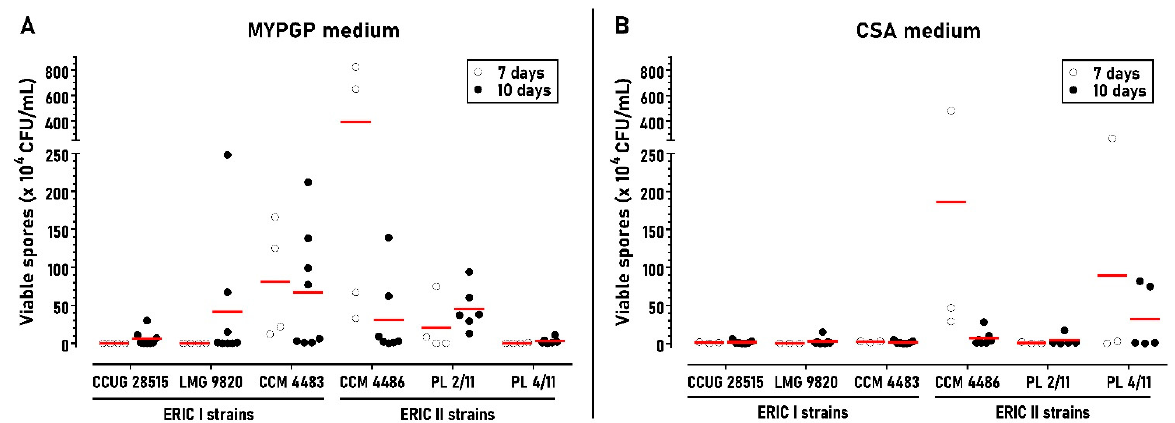
Figure 1. Effect of cultivation time on spore yields of P. larvae strains in the standard protocol. ( A ) Strains cultivated on MYPGP plates for 7 days ( n = 4) or 10 days ( n = 6–8). ( B ) Strains cultivated on CSA plates for 7 days ( n = 3) or 10 days ( n = 5–7). Red lines represent the means of the measured